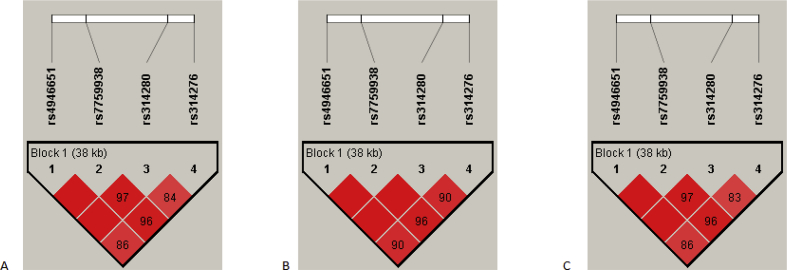
The structure of linkage disequilibrium of rs4946651, rs7759938, rs314280 and rs314276 in the LIN28B gene in the sample of Russian women. Linkage disequilibrium was measured by Lewontin's coefficient D′. The dark red (D′ = 1) indicates that there exists strong pairwise LD between SNPs. A) All sample set. B) Early age at menarche (<12 years). C) Average age at menarche (12–14 years).